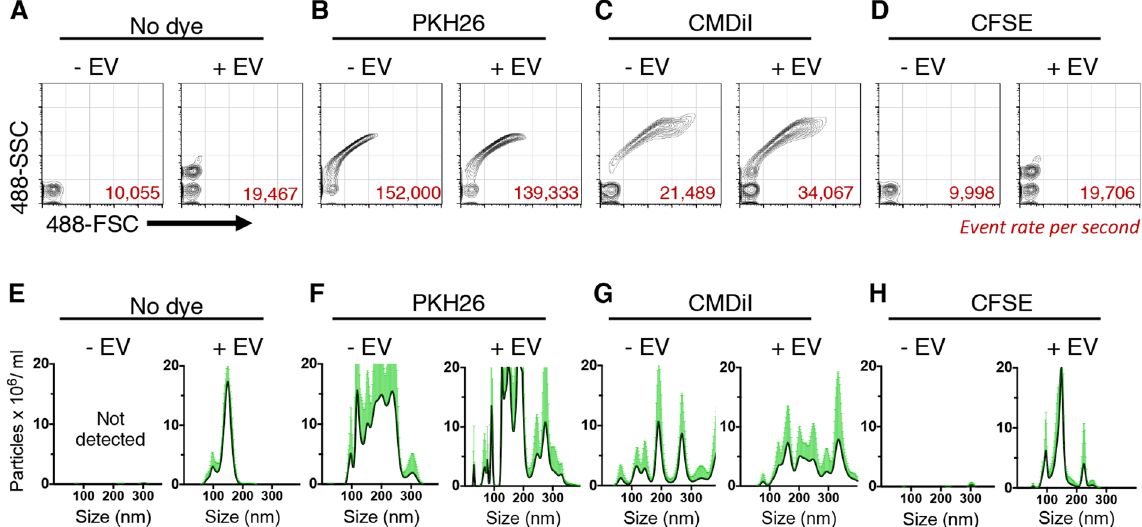
Figure 3. EV label suitability analysis by nanoFACS HR-FCM and NTA. nanoFACS analysis of light scattering pattern and event rate ( A–D ), and assessment of concentration and size distribution by NTA ( E–H ) of the following samples: PBS control and unstained EVs diluted in PBS ( A , E ), PKH26 alone in PBS or in the presence of EVs ( B , F ), CM-DiI alone in PBS or with EVs ( C , G ) and CFSE alone in PBS or with EVs ( D , H ). Side by side comparisson between PBS control and dye alone was used to interrogate the non-specific formation of micelles or other forms of dye aggregation. All the samples were stained and tested on the same day, under the same nanoFACS and NTA setup conditions to avoid interexperimental variations. Representative data from three independent experiments is shown. NTA histograms represent the mean of three replicate meassurements of the same sample and SD in green. EV, extracellular vesicle; FSC, forward and SSC, side light scatter; NTA, Nanoparticle Tracking